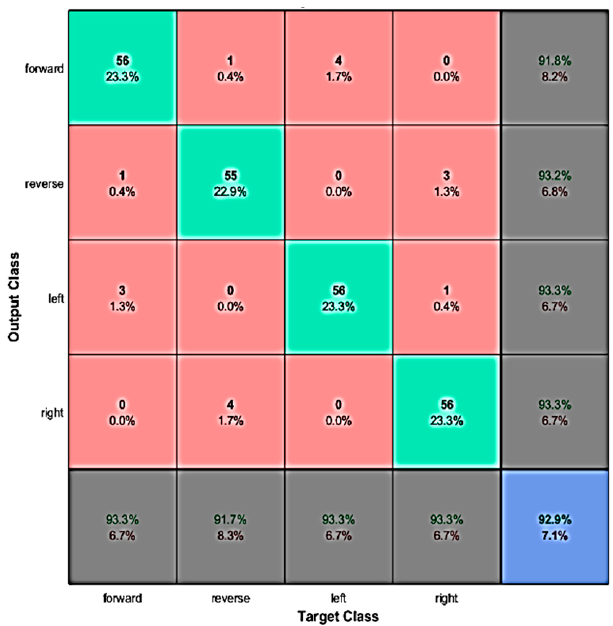
Figure 10. Confusion matrix for female subjects.